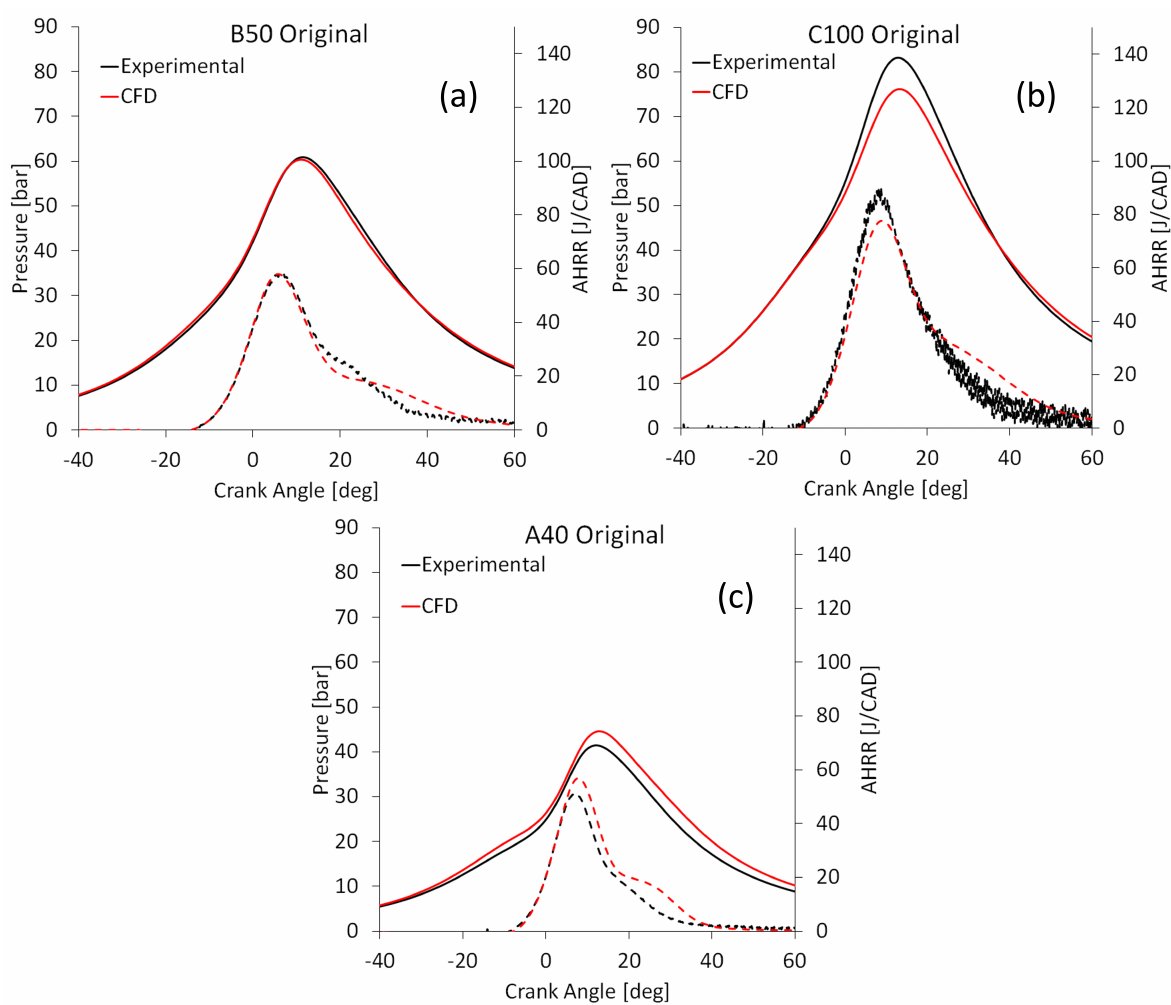
Figure 10. Comparison between the computed and experimental data of the in-cylinder pressure (solid lines) and apparent heat release rate (dashed lines) for the medium-load ( a ), high-load ( b ), and low-load ( c ) conditions when using the original